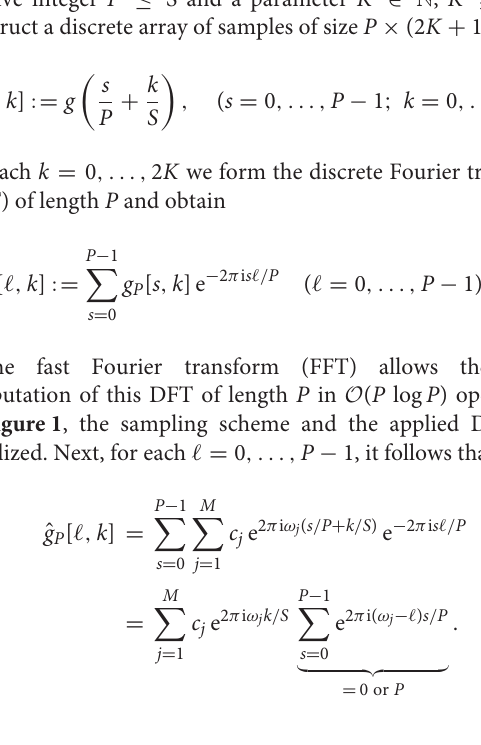
TABLE 2 | Computational costs for the Algorithms 2.8 and 2.9 in the case of N given samples, where S is a large even integer so that all frequencies